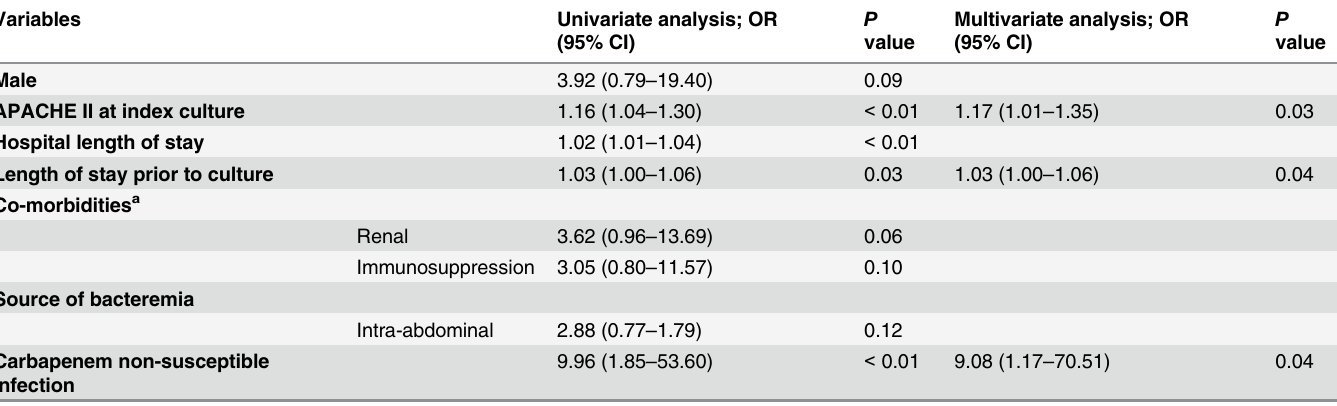
Table 2. Logistic regression analysis for the risk factors for 30-day hospital mortality. Only variables with P < 0.2 in the univariate analysis are